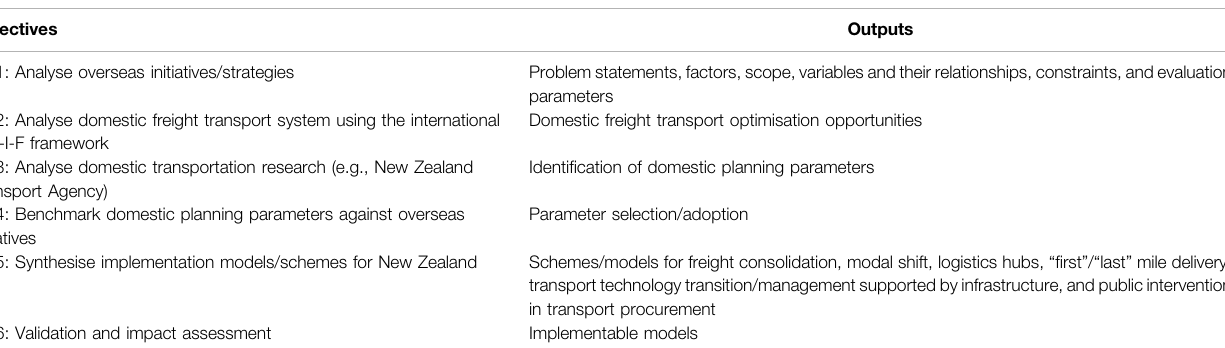
TABLE 3 | Research Objectives and their potential outputs (Authors ’ conception). Objectives